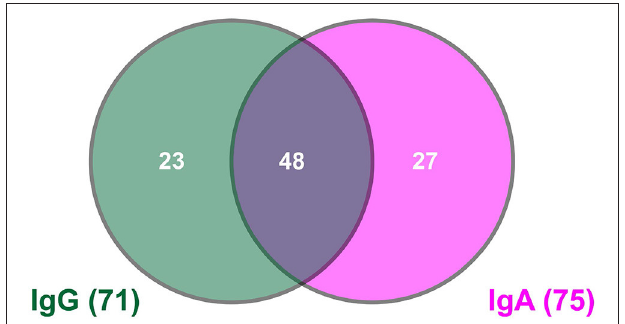
FIGURE 1 | Venn diagram showing the number of cases with SARS-CoV-2-specific antibodies.